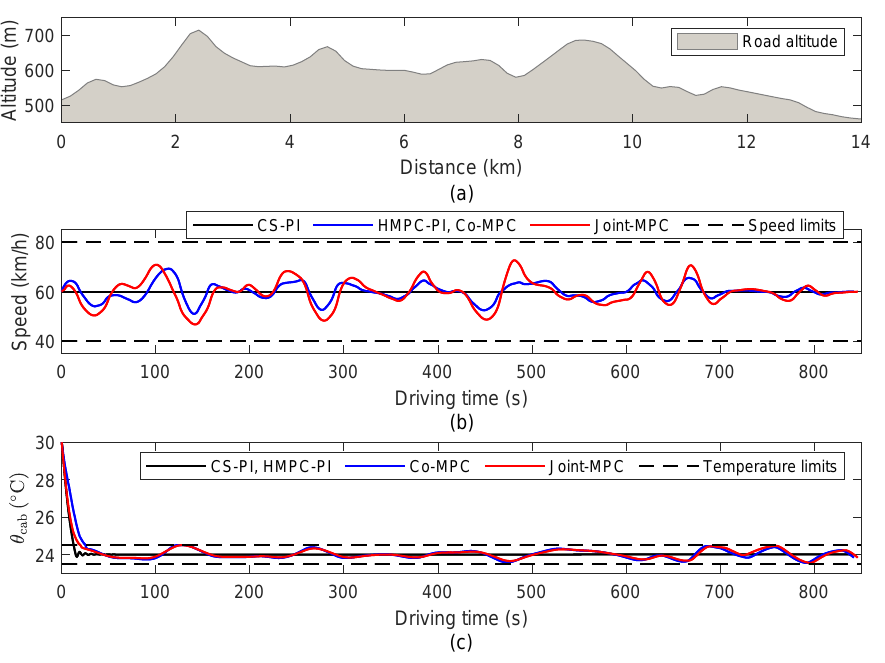
Figure 9. Simulation results of the second case study in recirculation mode. ( a ) Altitude profile of the hilly road; ( b ) Speed trajectories for different methods; ( c ) Cabin air temperature trajectories for different methods.